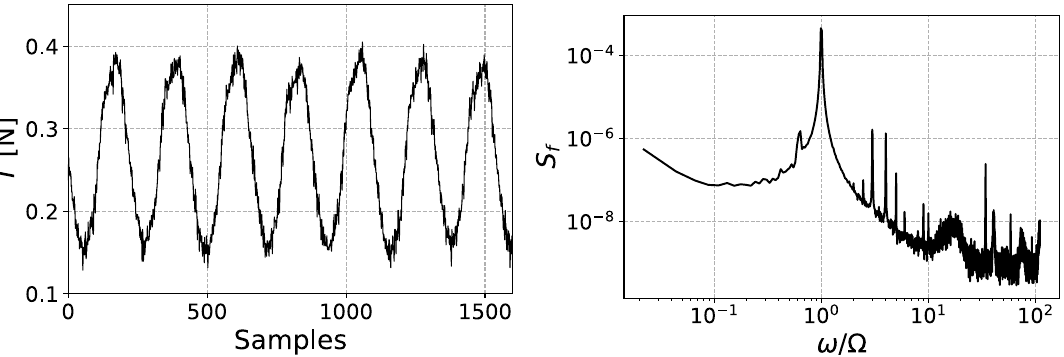
Figure 12. Thrust ( left ) and power density spectrum ( right ) for a balanced rotor at Ω = 285